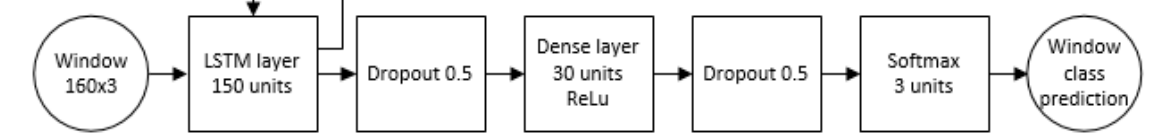
Figure 3. Signal propagation through the LSTM architecture.